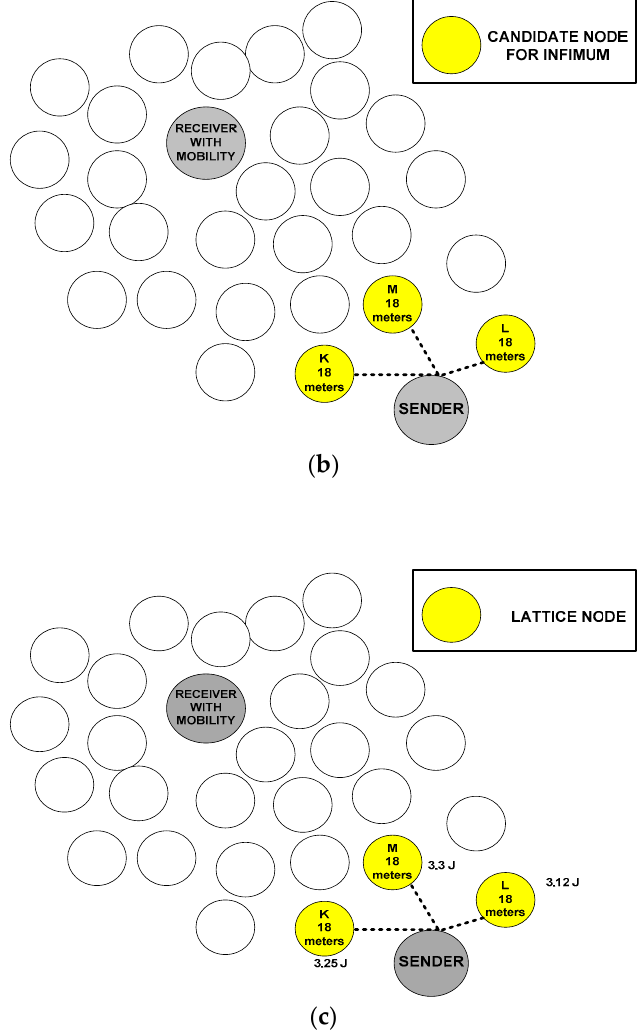
Figure 2. ( a ) Selection of the supremum node based on the highest residual energy using the upper bound. ( b ) Selection of the infimum node based on the shortest distance using the greatest lower bound. ( c ) Selection of the lattice node based on the shortest distance and highest residual energy using greatest lower bound and upper bound, respectively (satisfying both conditions of supremum and infimum).